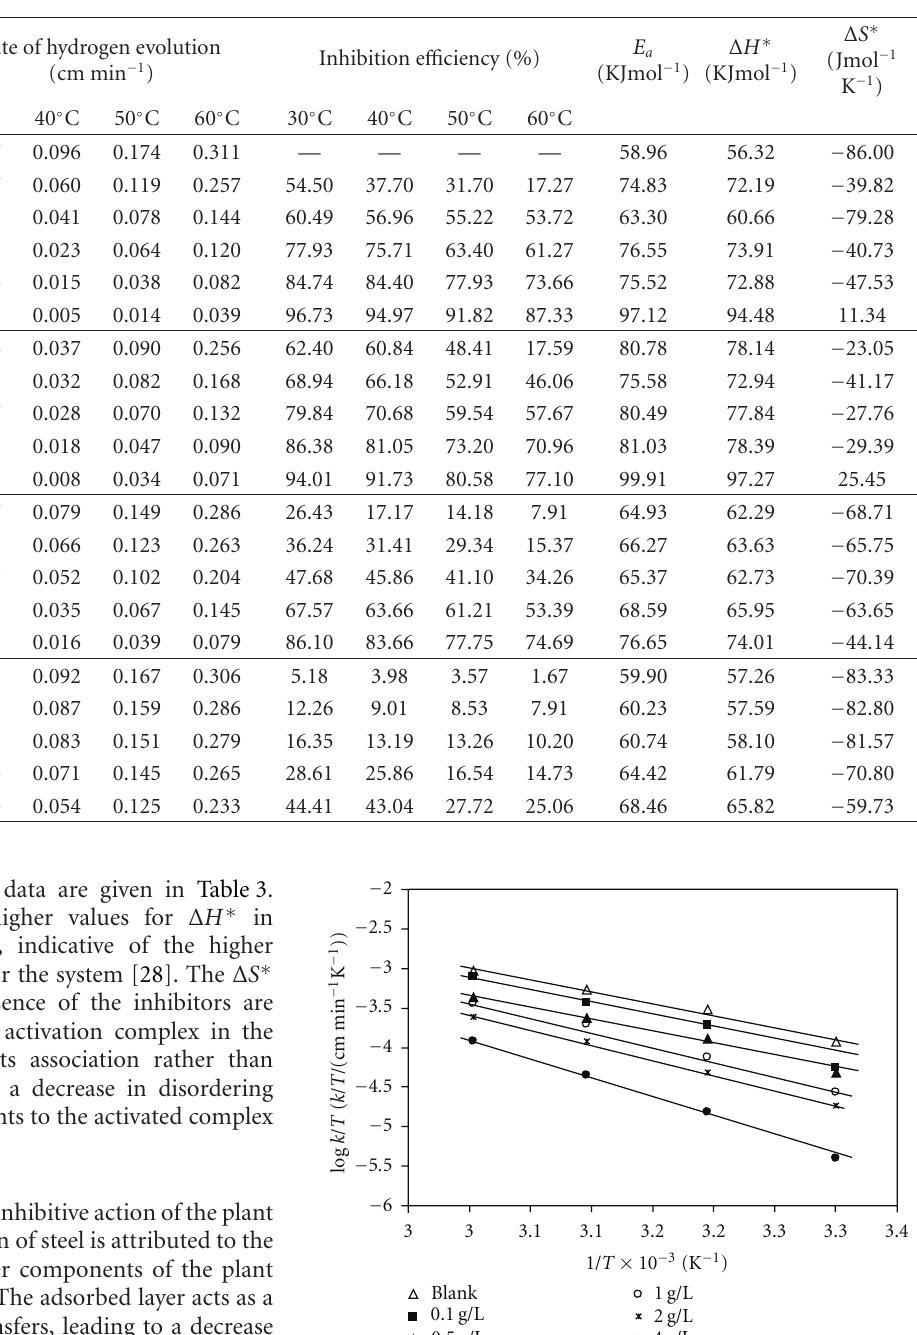
Table 3: Kinetics and activation parameters for mild steel coupons in 5.0M H 2 SO 4 solutions in the absence and presence of inhibitors (using the gasometric technique).